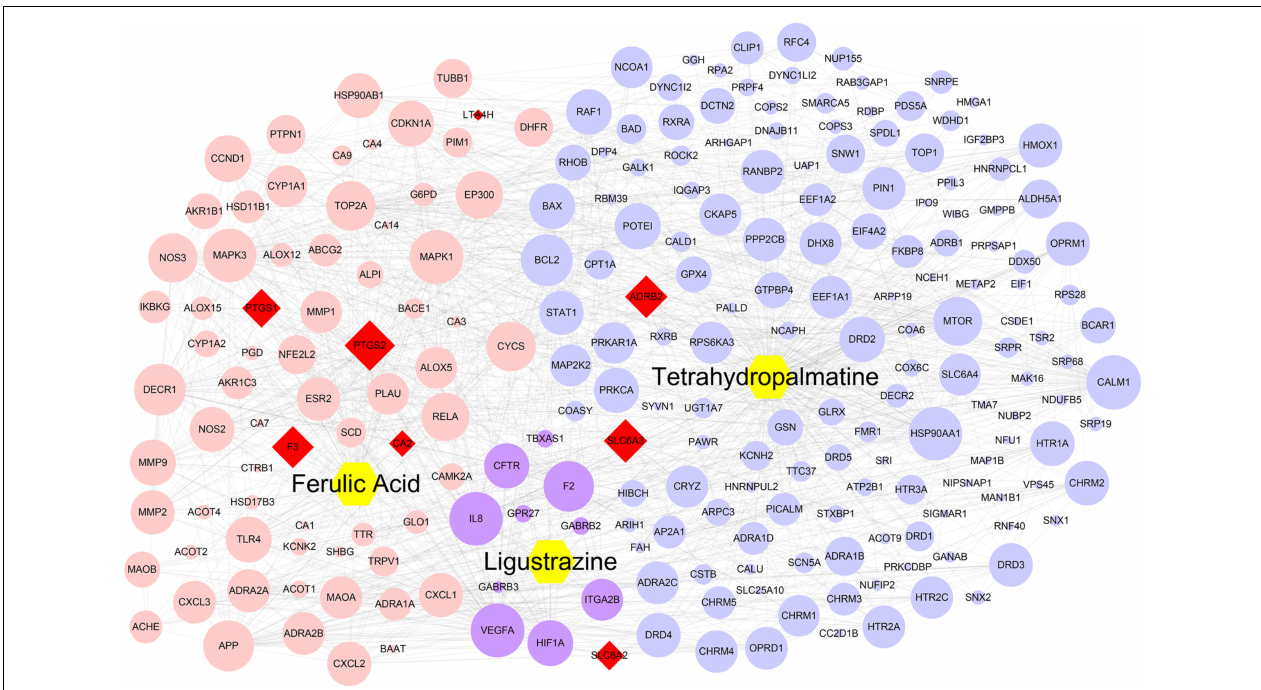
FIGURE 2 | The compound–compound target network. Purple circles, pink circles, blue circles, and red diamonds represented the targets of ligustrazine, ferulic acid, tetrahydropalmatine, and the common targets for all three components, respectively. Yellow hexagons represented the three compounds of Jiawei Foshou San . The size of circles and diamonds represented nodes degree